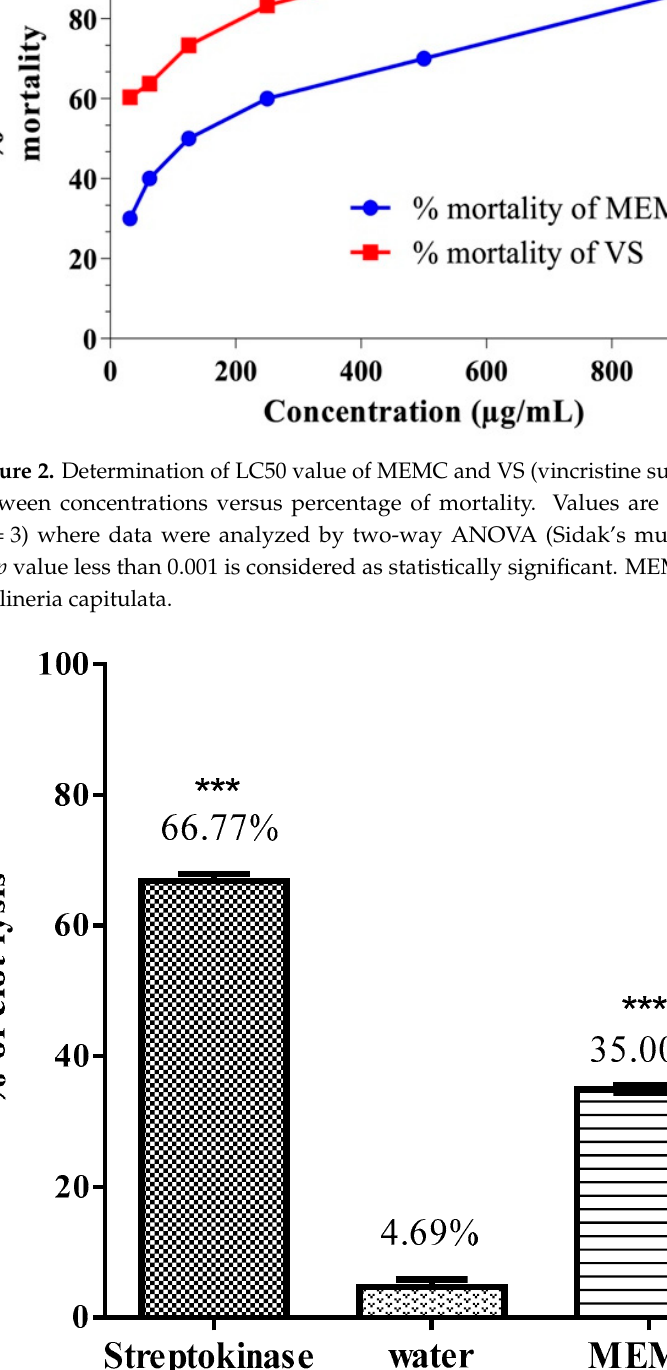
Figure 3. Thrombolytic activity of MEMC (methanol leaf extract of Molineria capitulata). Percentage of clot lysis of MEMC in comparison with negative control (water). Values are expressed as mean ± SEM for 10 volunteers, where data were analyzed by Dunnett’s test and *** p value less than 0.001 is considered as statistically significant.